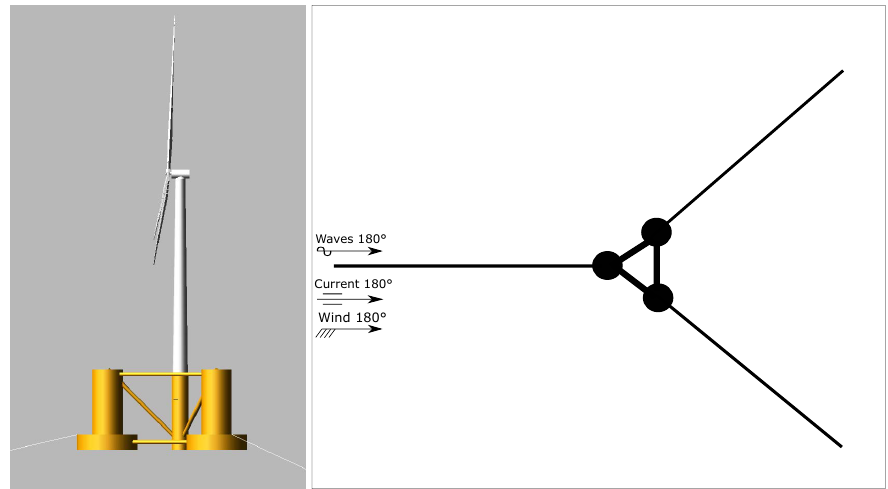
Figure 1. ( Left ) OC4-DeepCWind FOWT design. ( Right ) Top view of the mooring system of the OC4-DeepCWind FOWT